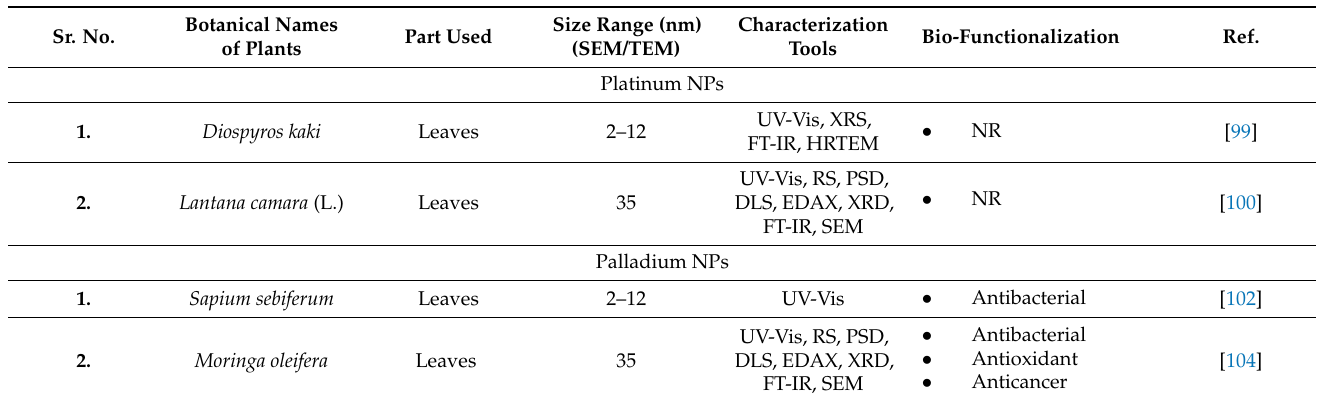
Table 4. Bio-reduction of platinum group NPs and their